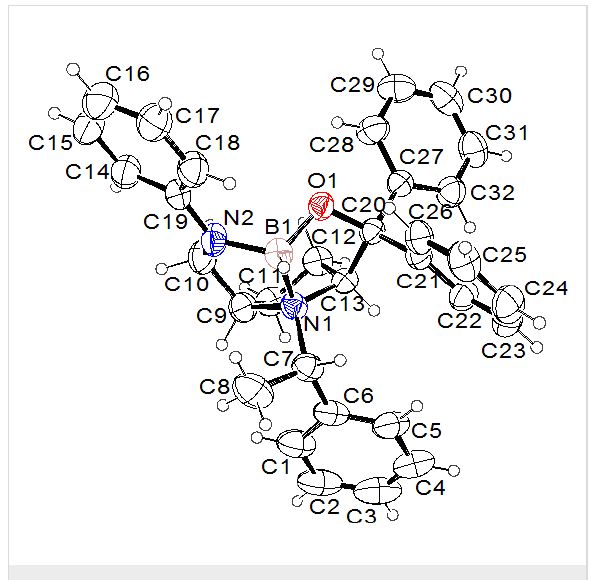
Figure 3: X-ray crystal structure of compound 5a .